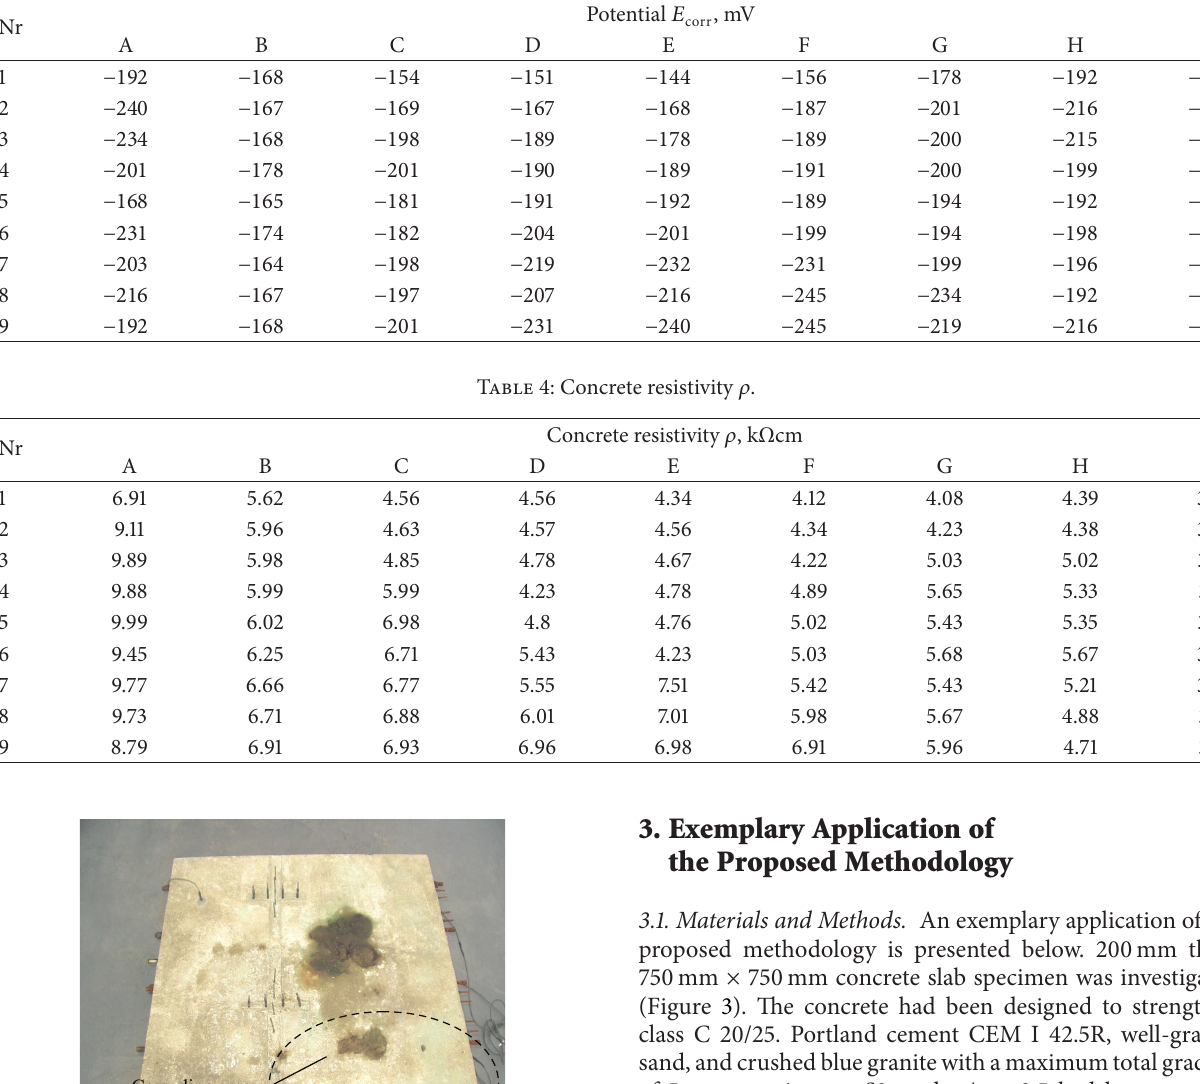
Table 3: Potential 𝐸